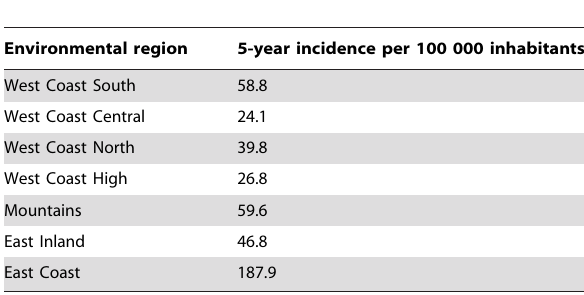
Table 1. 5-year snakebite incidence in environmental